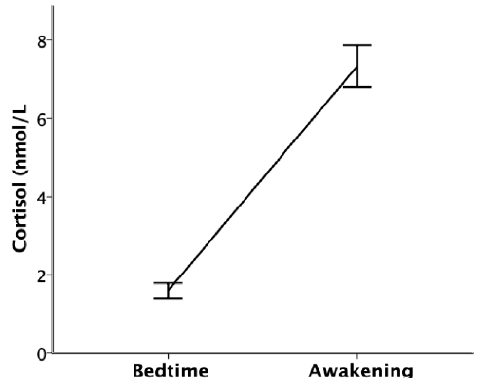
Figure 1. Cortisol levels (nmol / L) at bedtime and immediately after awakening. Error bars represent standard error.